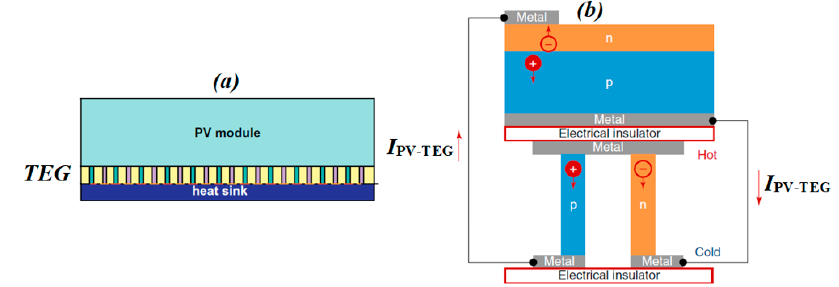
Figure 1. Schematic overview of the HPVTEG system.